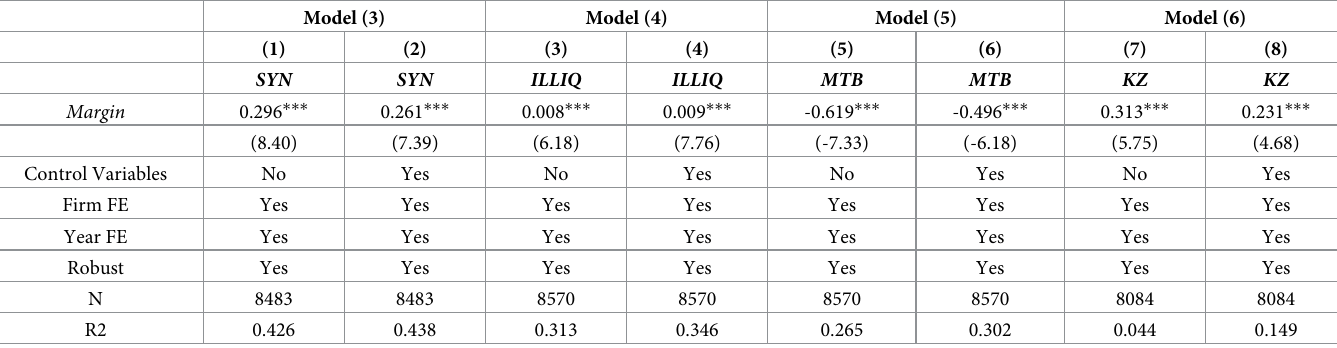
Table 14. Impact of margin trading on the information environment and financing